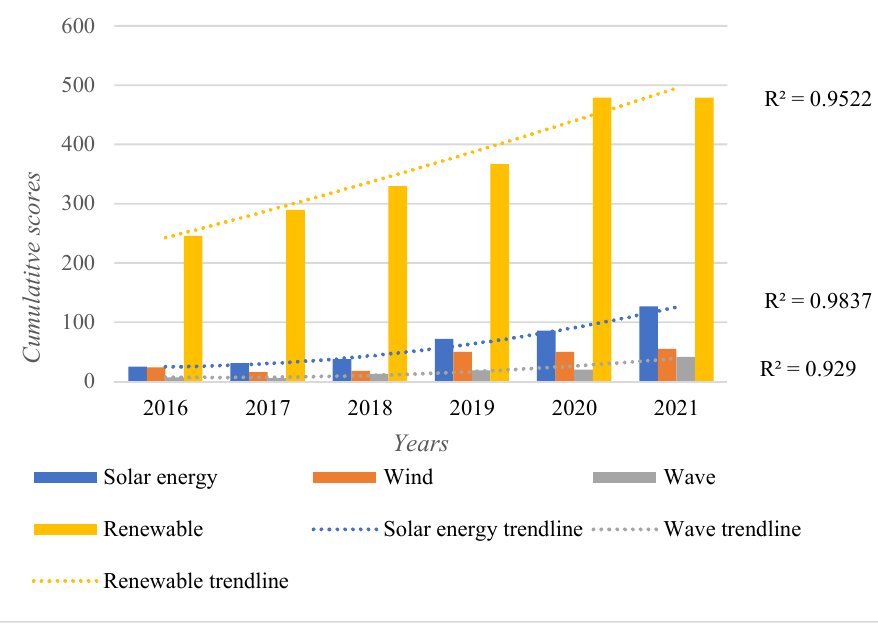
Figure 7. Citations on renewable energy sources in the context of energy security education.